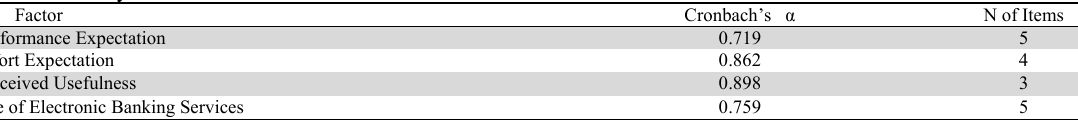
Results reliability for each factors